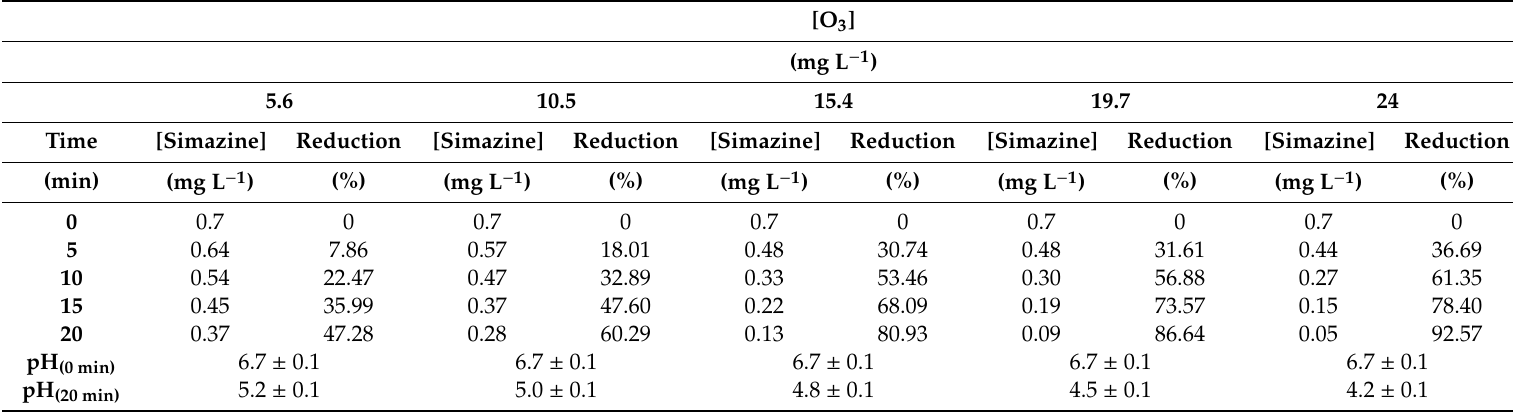
Table 2. The simazine concentration and the pH obtained in the ozone treatment at a contact time of 20 min and temperature of 25 ◦